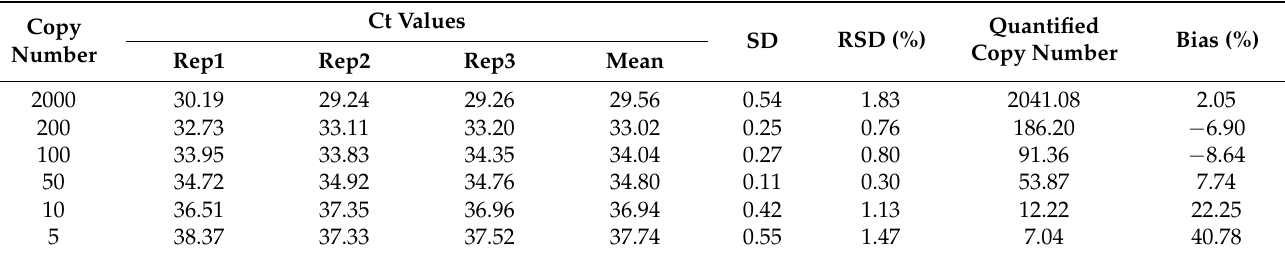
Table 2. Limit of detection (LOD) and limit of quantification (LOQ) determination for the event-specific real-time PCR assay using different dilutions of transgenic hLZ goat DNA for